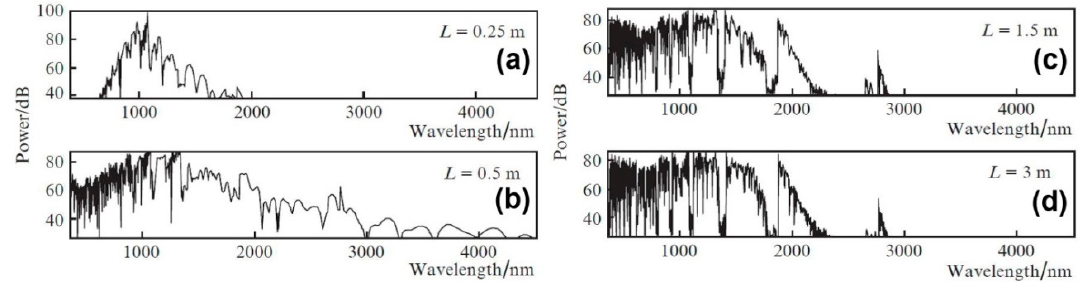
Figure 19. ( a – d ) Calculated supercontinuum spectra at different RF lengths for pure single-mode propagation at an input pulse energy of 110 μ J for various fiber lengths from 0.25 to 3 m [80].